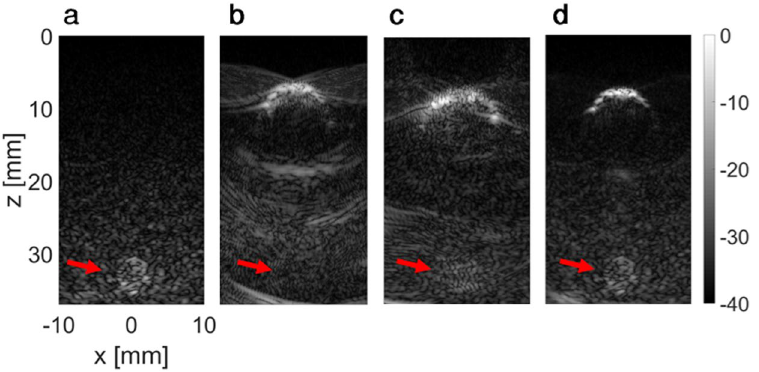
Figure 7. Application of the BUS technique for lesion detection in a tissue mimicking phantom. Images presented in 40 dB dynamic range, and the colorbar is common to all subfigures. Axes are common to subfigures ( a – d ). ( a ) Reference two-way focused ultrasound image of the 3-mm lesion positioned at ~32 mm (indicated by the red arrow). ( b ) Two-way focused ultrasound image of the same phantom with a 10-mm air bubble located at a depth of 10 mm. The lesion cannot be seen due the presence of the obstacle. ( c ) Using the optimized PI method, the lesion is dimly visible. ( d ) Using the BUS method, the lesion is fully visible.